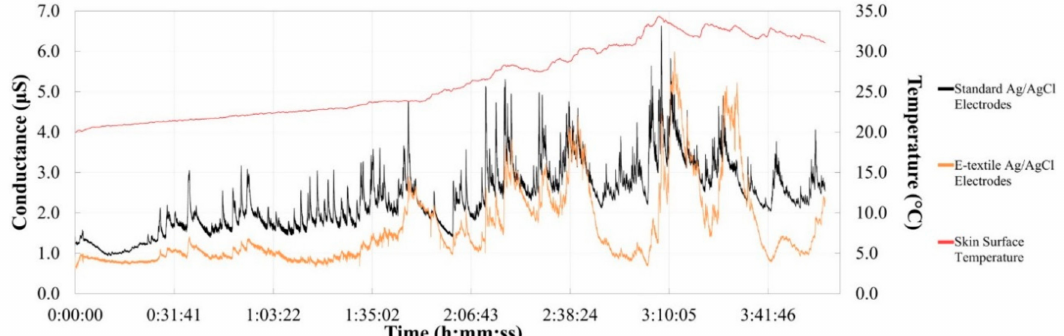
Figure 9. 4-h EDA data shown by conductance (primary y -axis) for dry e-textile electrodes (0.12 cm 2 surface area, 0.40 cm distance) on the distal phalanx of the middle finger compared to dry commercial electrodes (1.00 cm 2 surface area, 1.50 cm distance) on the proximal and medial phalanges of the middle finger. Skin surface temperature is also shown (secondary y -axis) with time in seconds ( x -axis).